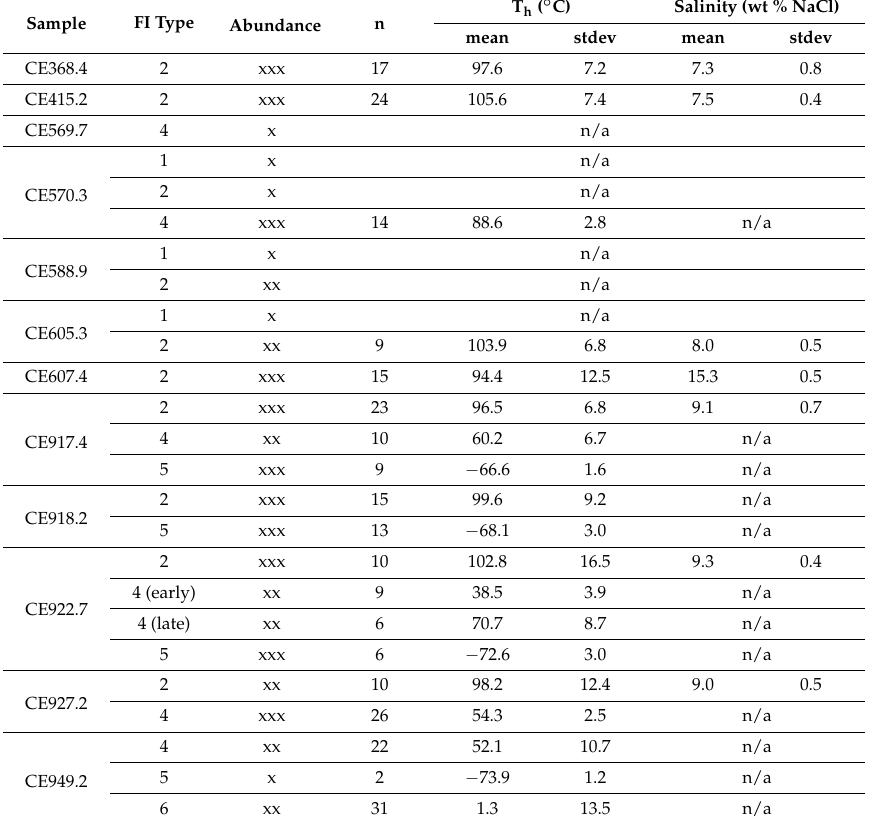
Table 3. Distribution, relative abundance and microthermometric data from fluid inclusions in samples from Parsons Pond. xxx = abundant. xx = common. x =